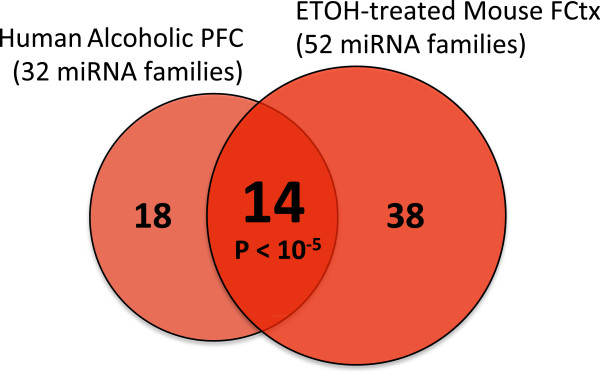
Upregulation of frontal cortex miRNAs in response to alcohol is conserved from mice to humans. Venn diagram highlights common set of 14 upregulated miRNA families in prefrontal cortex of human alcoholics [11] and ethanol-treated mice (current study). P value empirically assessed after 100,000 Monte Carlo simulations. PFC: prefrontal cortex, FCtx: frontal cortex.